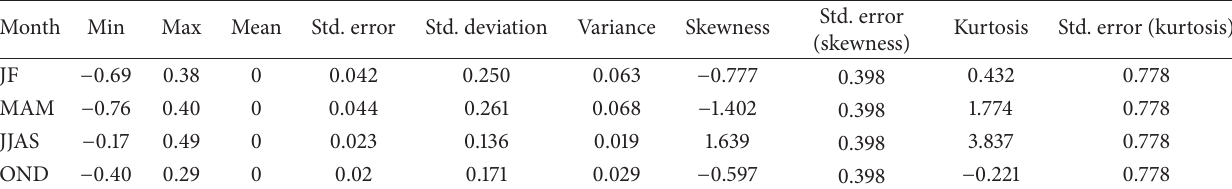
Table 1: General statistics of GPCP.